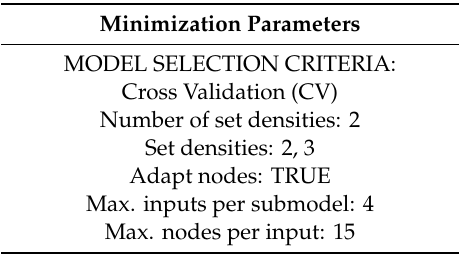
Table 2. Training parameters for model construction by FormRules 4.03 ®